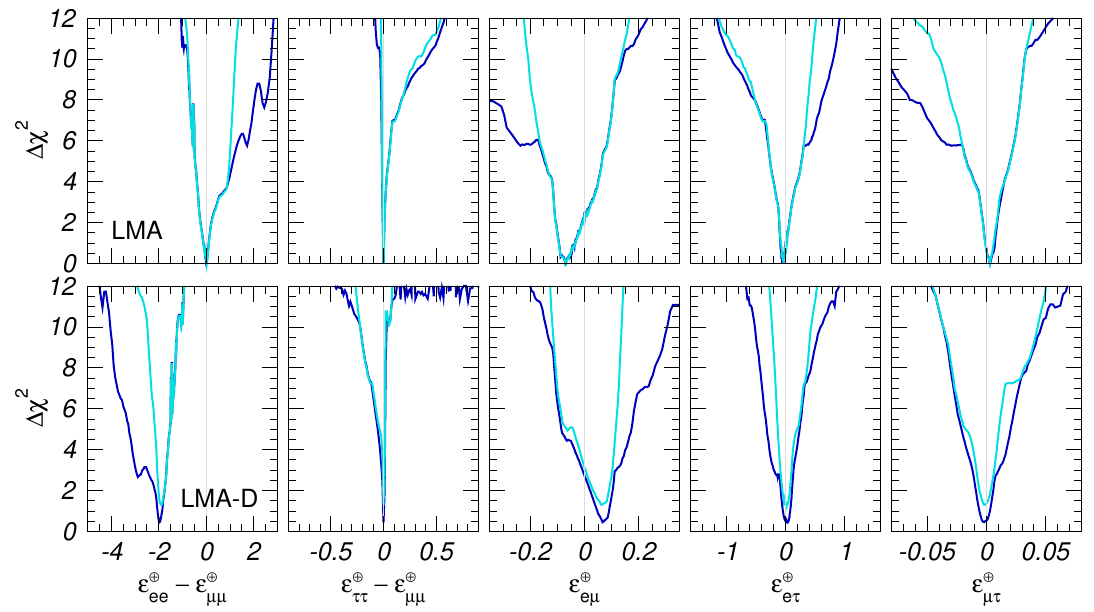
Figure 3 . Dependence of the ∆ χ 2 function on the effective NSI parameters relevant for matter effects in LBL experiments with arbitrary values of η , from the global analysis of solar, atmospheric, LBL-CPC and reactor data (blue lines) and including also COHERENT (cyan lines). The upper (lower) panels correspond to solutions within the LMA (LMA-D) subset of parameter